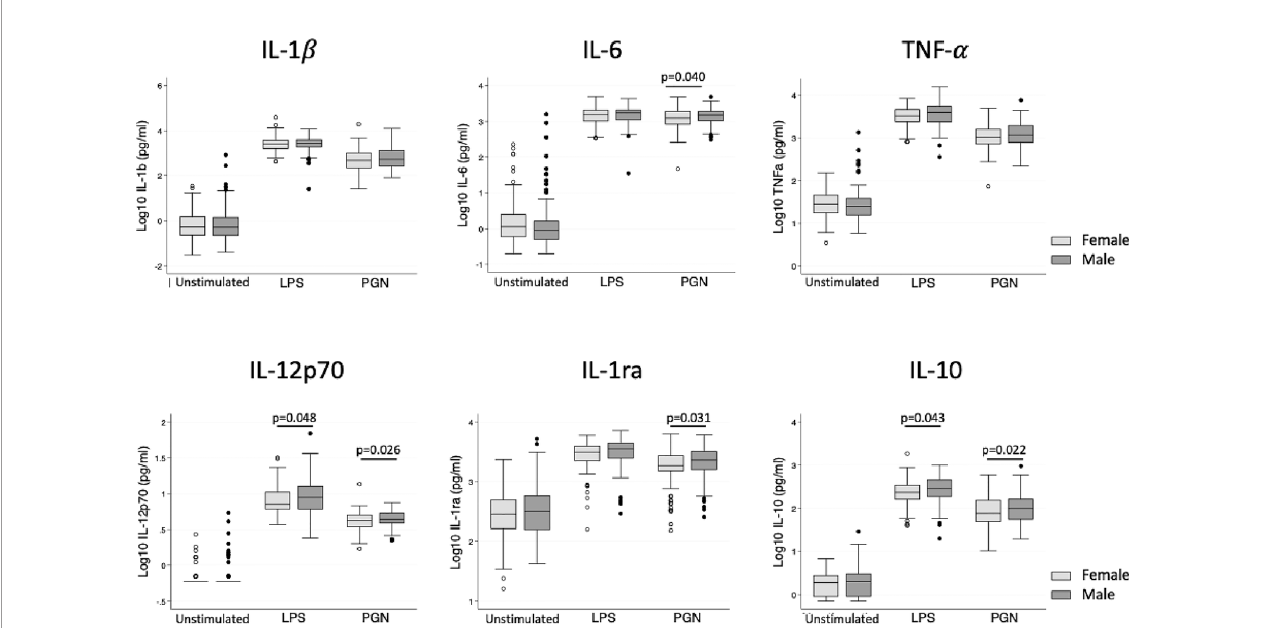
FIGURE 1 | Cytokine levels following in vitro stimulation with TLR ligands in female and male children. Box plot graphs (with median and upper and lower quartiles) of cytokine levels (Log 10 (pg/ml)) from whole blood following 24 hour stimulation with medium (unstimulated), LPS (TLR4 stimulation) and PGN (TLR2 stimulation), n=285 (149 males, 136 females). Male children had modestly higher production of IL-12p70 and IL-10 upon both LPS and PGN stimulation and additionally higher IL-6 and IL-1RA upon PGN stimulation (unadjusted linear regression at each treatment).